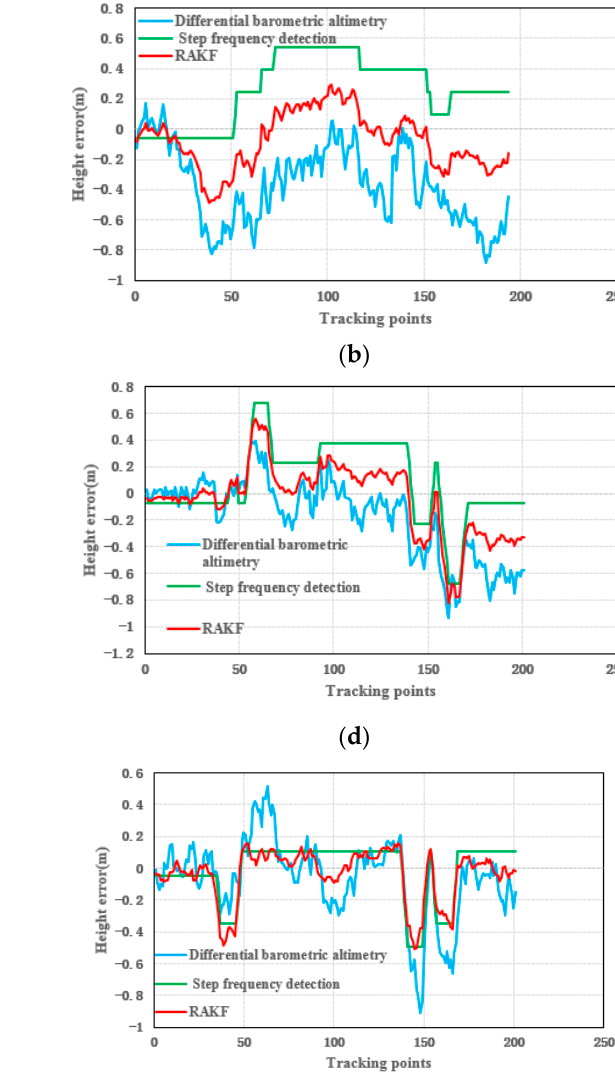
Table 2. Statistical results of height error in the test (m).